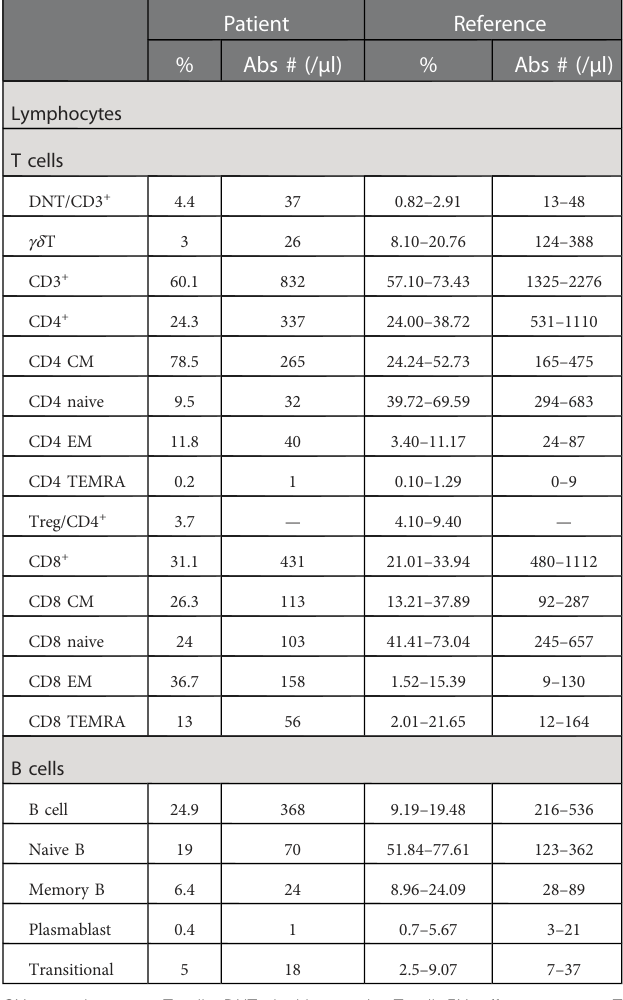
TABLE 1 Lymphocyte subsets of the patient.